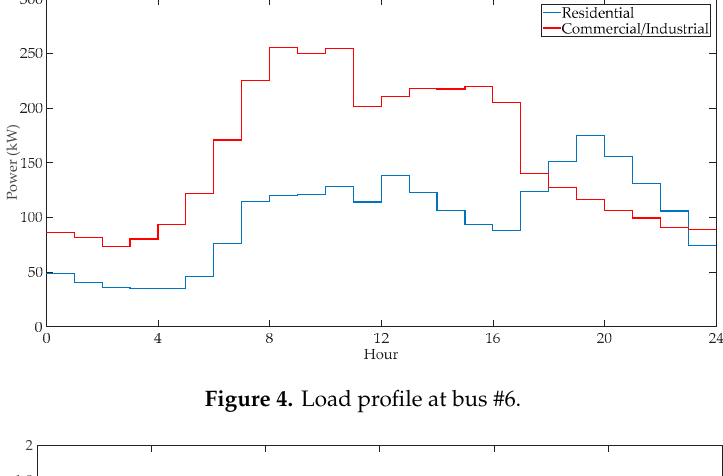
Figure 4. Load profile at bus #6.